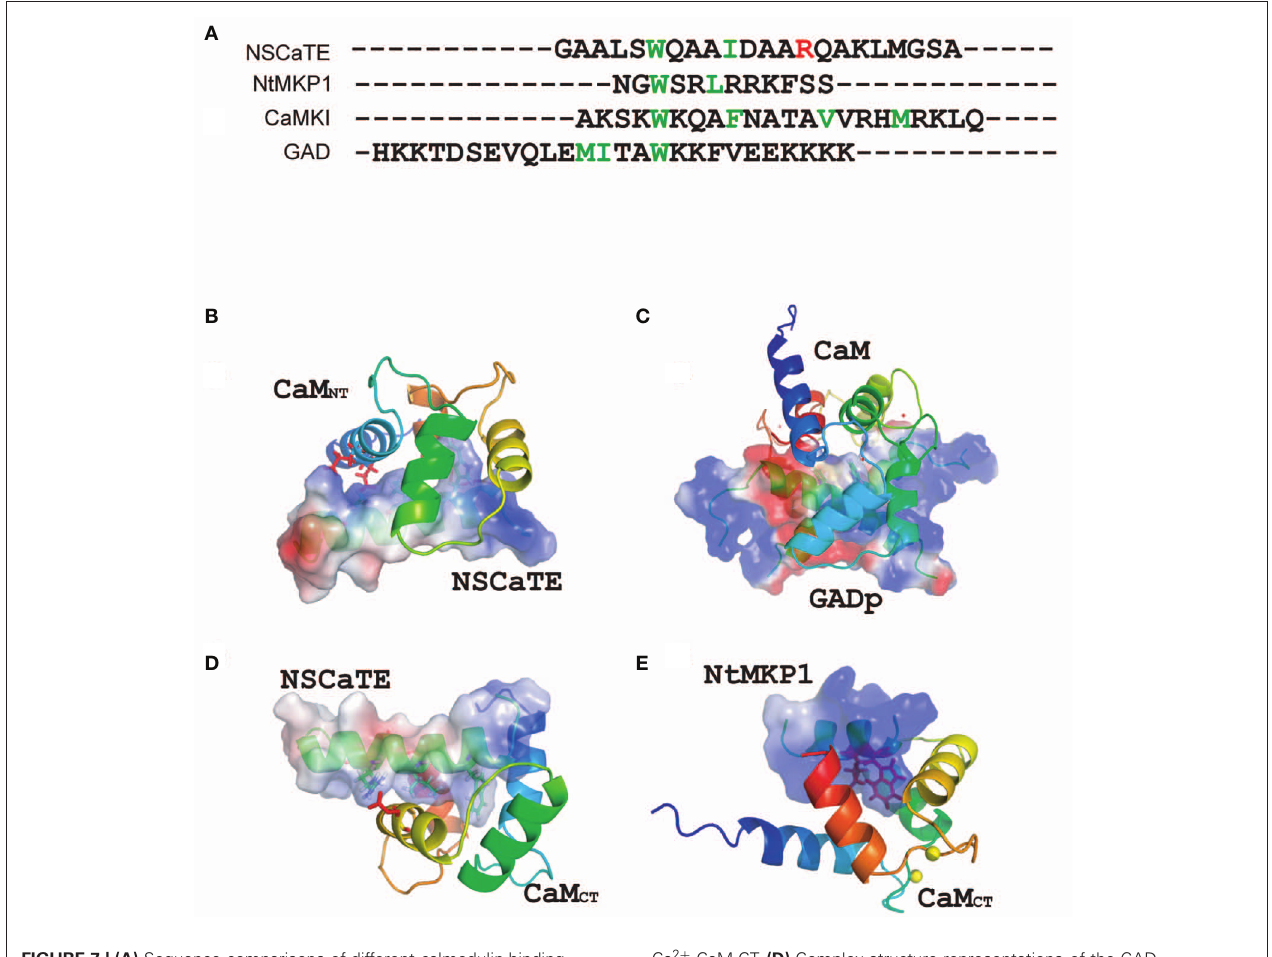
Ca 2 + -CaM CT. (D) Complex structure representations of the GAD peptide and Ca 2 + -CaM (PDB ID: 1NWD). (E) Complex structure representations of the NtMKP1 peptide and Ca 2 + -CaM CT (PDB ID: